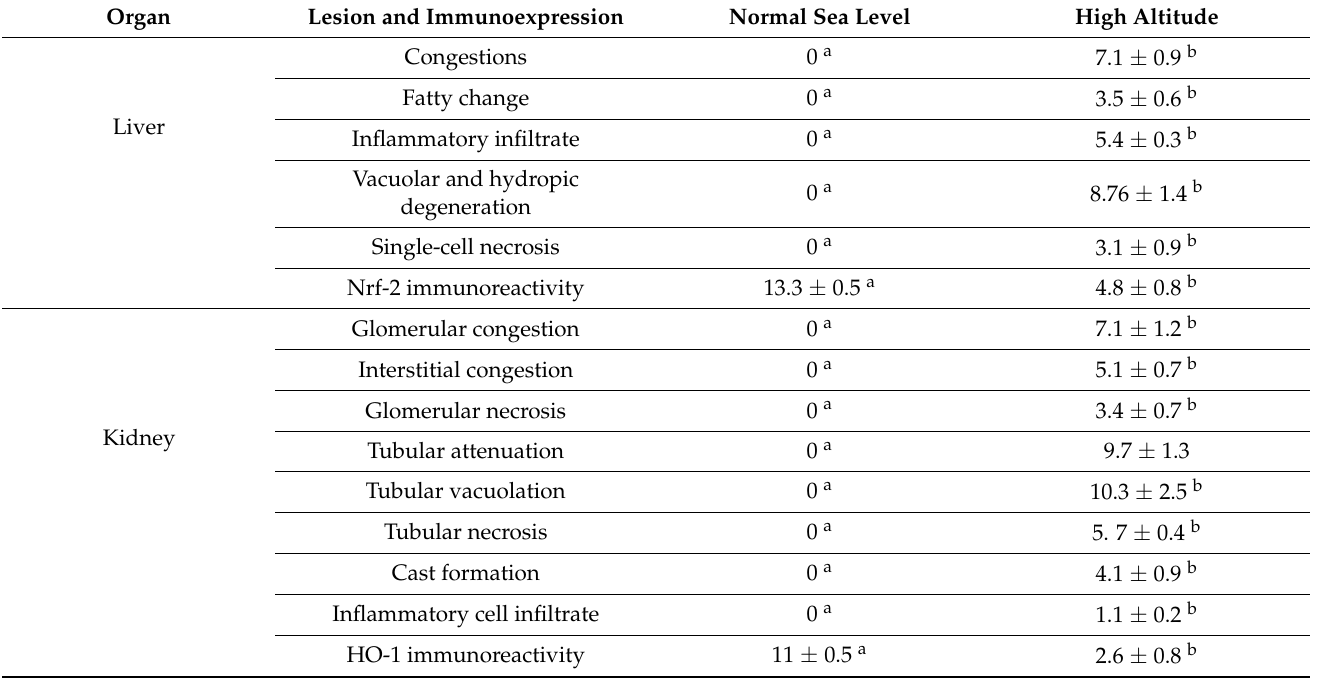
Table 5. Histopathological changes as described by H&E and immunoexpression of HO-1 and Nrf-2 in the hepatic and renal tissues of rats who lived at sea and high altitude